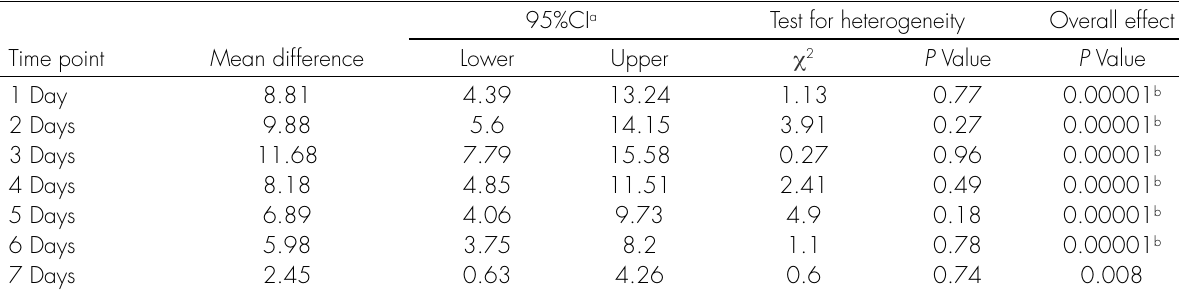
Table VI. Meta-analysis data summary: Structured phone call follow-up vs control group.